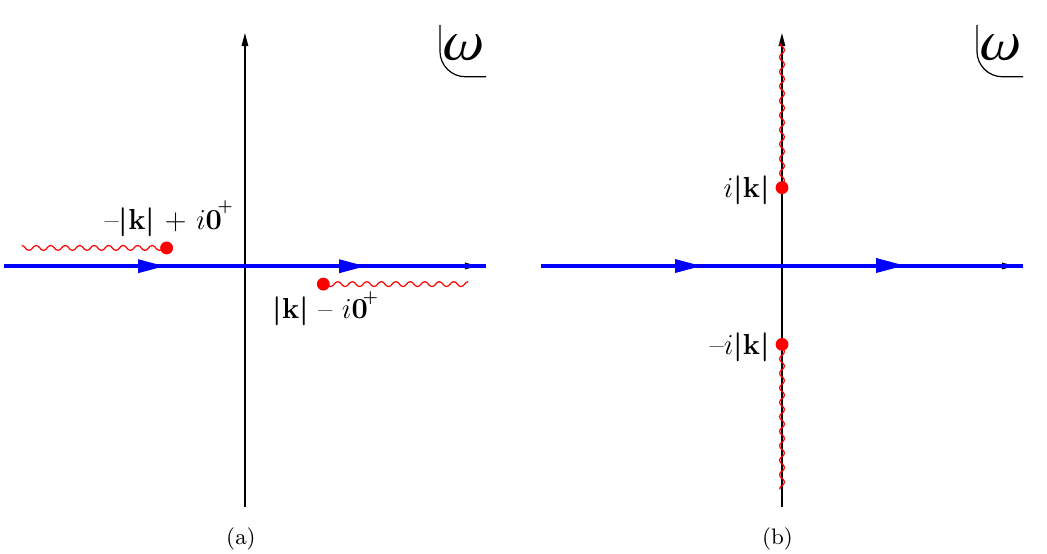
Figure 3 . (a) Position of the branch cuts (red) in the ! -complex plane and integration contour (blue) in (3.6). (b) Position of cuts and integration path for the boundary-bulk propagator in the euclidean